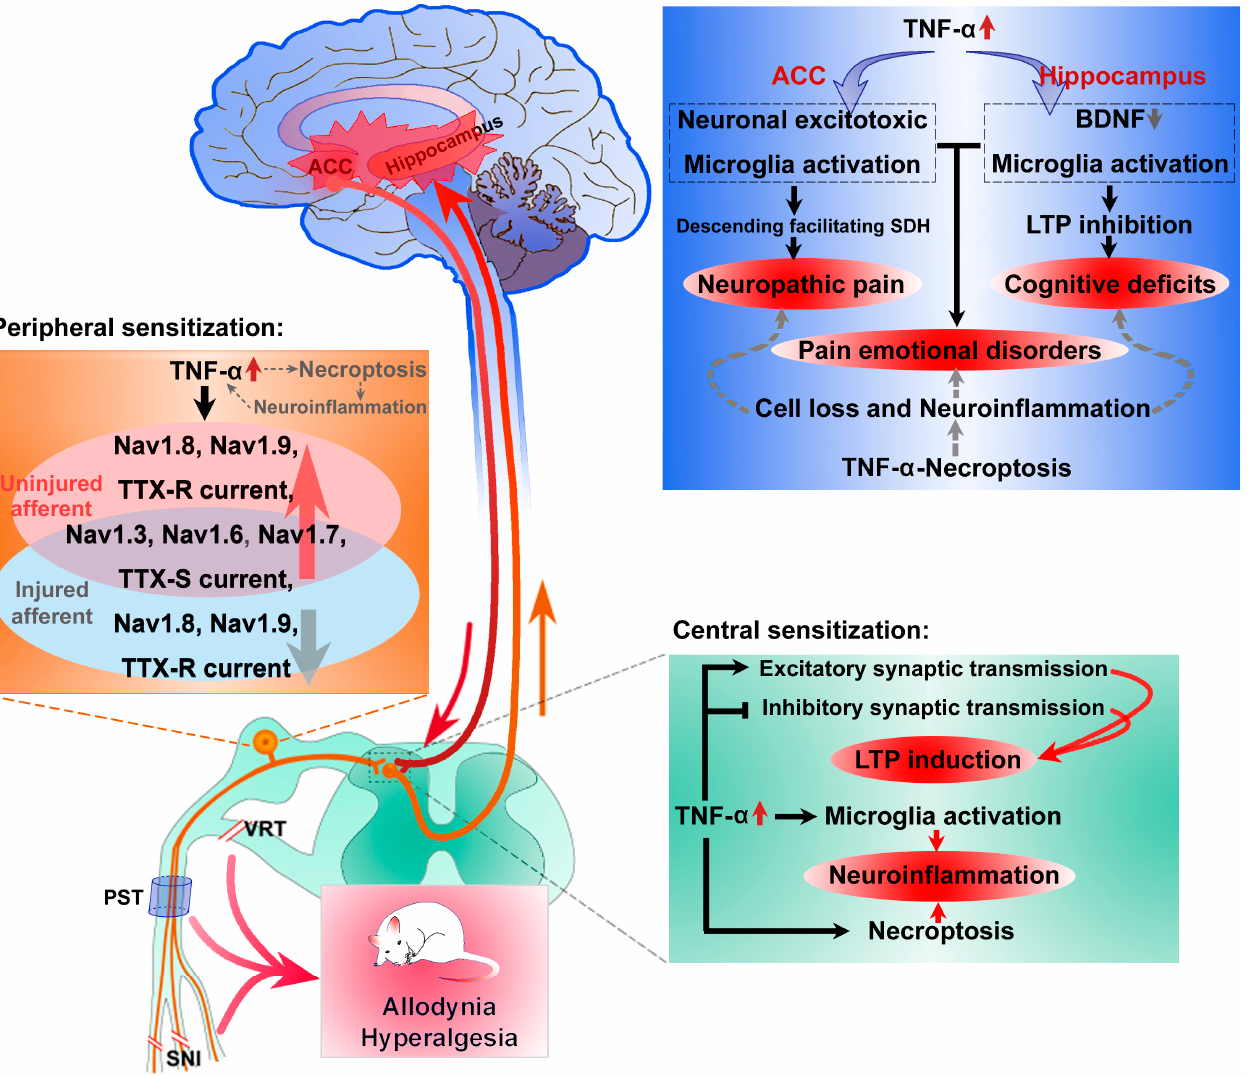
Figure 2. Potential mechanisms underlying peripheral and central sensitization via TNF- α or the TNF- α –necroptosis pathway in neuropathic pain. TNF- α regulates voltage-gated sodium channels (VGSCs) to sensitize primary afferents in the peripheral nervous system, affects excitatory and inhibitory synaptic transmissions in central nervous system (CNS), and evokes positive feedback between TNF- α and microglial activation to induce neuroinflammation, thus facilitating pain transmission, adverse pain-associated emotional reactions and cognitive deficits. TNF- α -triggered necroptosis in the dorsal root ganglia (DRG), spinal cord and supraspinal region may be one of the key factors for inducing neuroimmune responses in neuropathic pain.